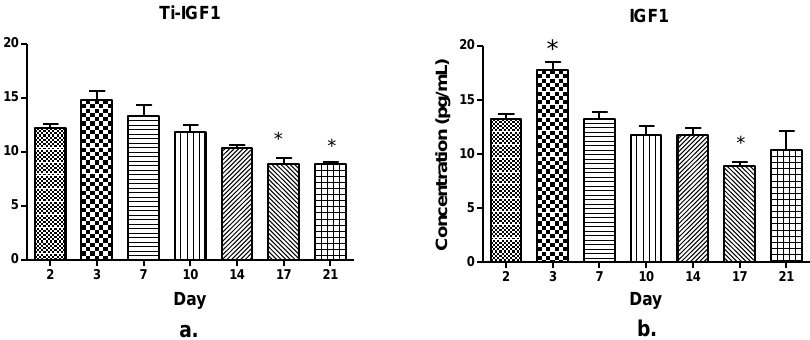
Figure 8. The concentration levels of insulin-like growth factor 1 at different time intervals (days 2–21) in the presence of titanium implants ( a ) and without titanium implants ( b ) in the culture media. *— p < 0.05, where p < 0.05 is considered the level of statistical